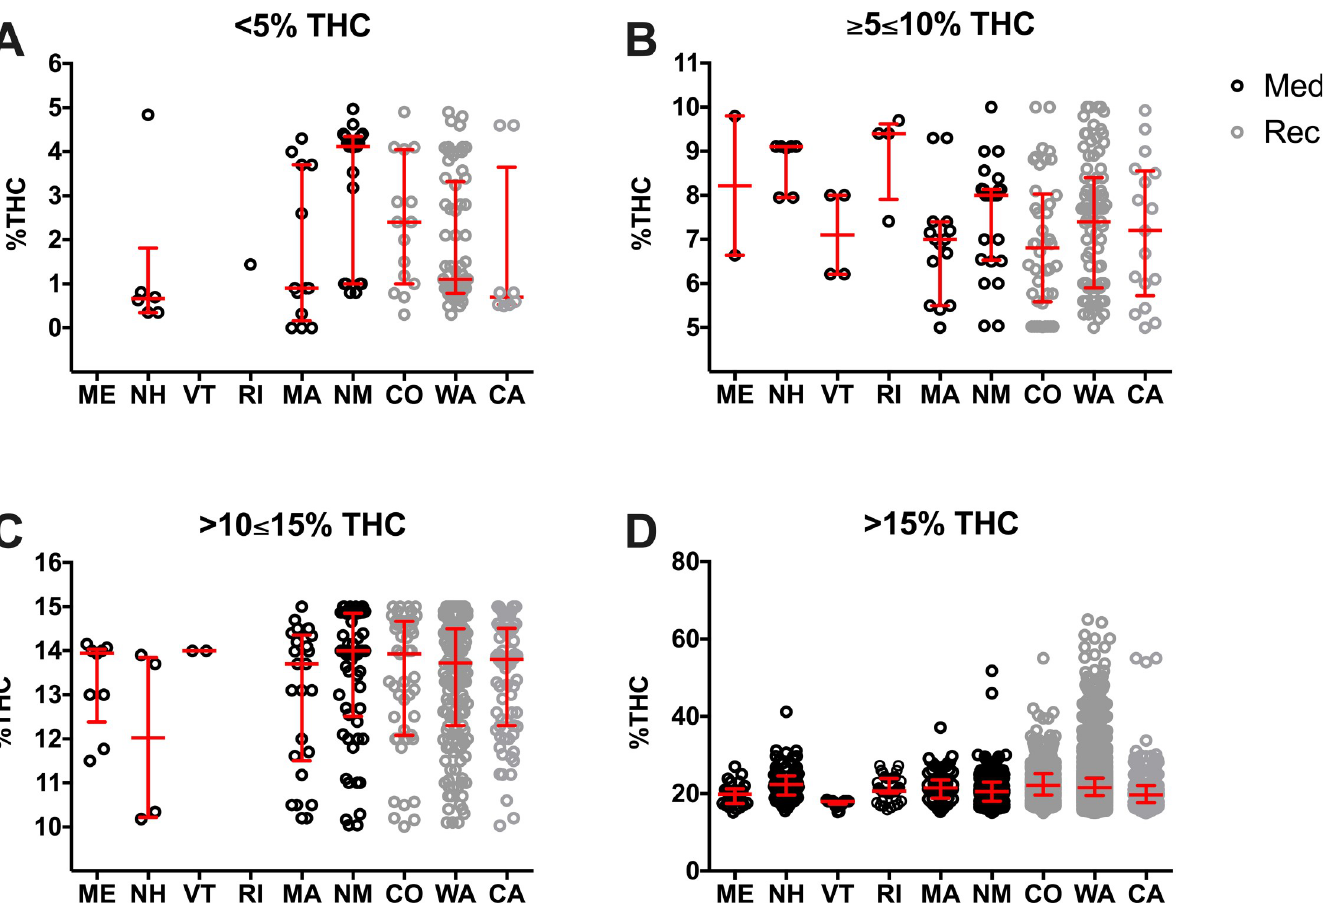
Fig 4. Percent THC at different strength product categories based on THC content per state. Products are presented in the following categories: < 5% THC (A), � 5 � 10% THC (B), > 10 � 15% THC (C), and > 15% THC (D). Every herb cannabis product in the surveyed states is plotted as an open circle. States with medicinal only (Med; black circles) and recreational and medicinal (Rec; grey circles) programs were compared. Data are presented as median with interquartile range. Statistic significant changes (P < 0.05) were observed between the following states: NM vs. WA in < 5% THC; NH vs. CO in � 5 � 10%. One-way ANOVA and Tukey’s multiple comparison test. For clarity we do not show the statistic differences among states in the > 15% category, these statistical analysis results and descriptive statistics could be found in S6 and S7 Tables. The outlier products in the graph might represent herbal products infused with concentrated THC or CBD extracts, however we did not observe such a claim in the studied websites where these products were